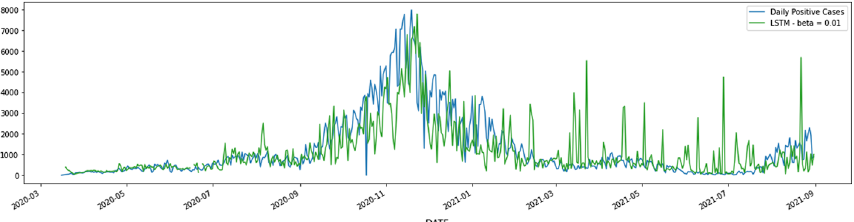
Fig. 5 Forecasting the number of daily positive cases in the state of Washington using the LSTM model with optimism bias regularization term